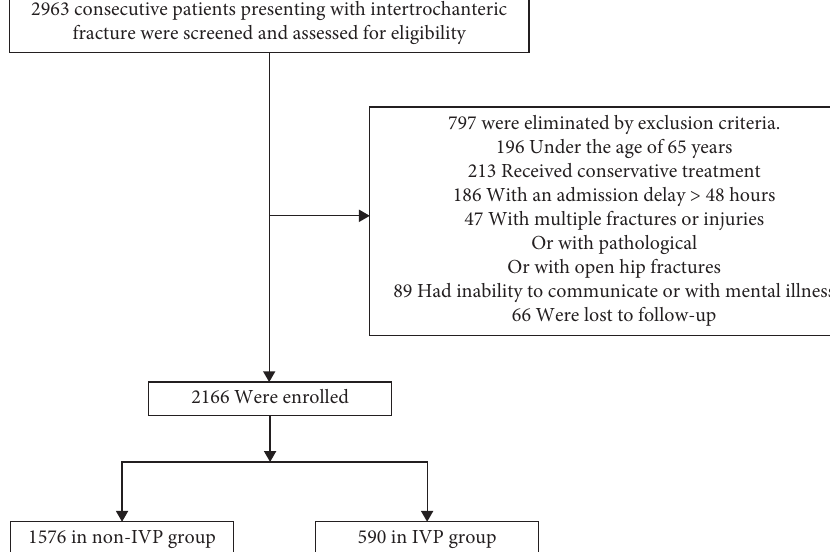
Figure 1: Flow diagram of included